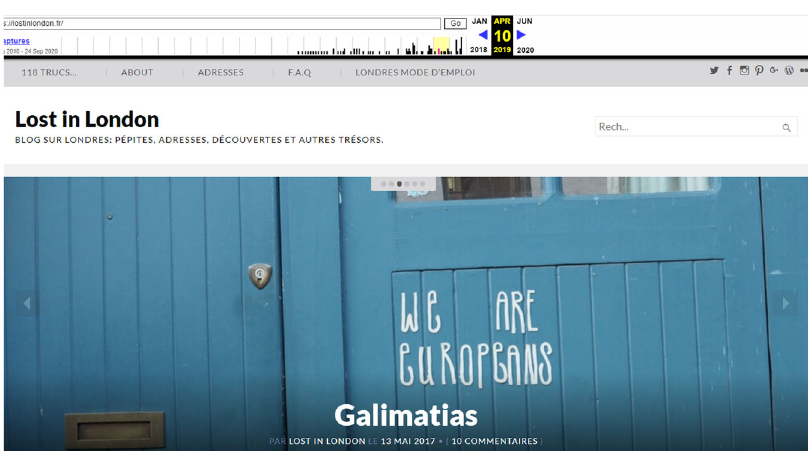
Fig. 6 Lost in London, archived 10 April 2019. Screenshot of the pared down landing page. The banner has been removed and six auto-rotating photographs fi ll the screen in succession. This fi gure is not covered by the Creative Commons Attribution 4.0 International License. Reproduced with permission of Fabienne Henry; copyright ©Fabienne Henry, all rights